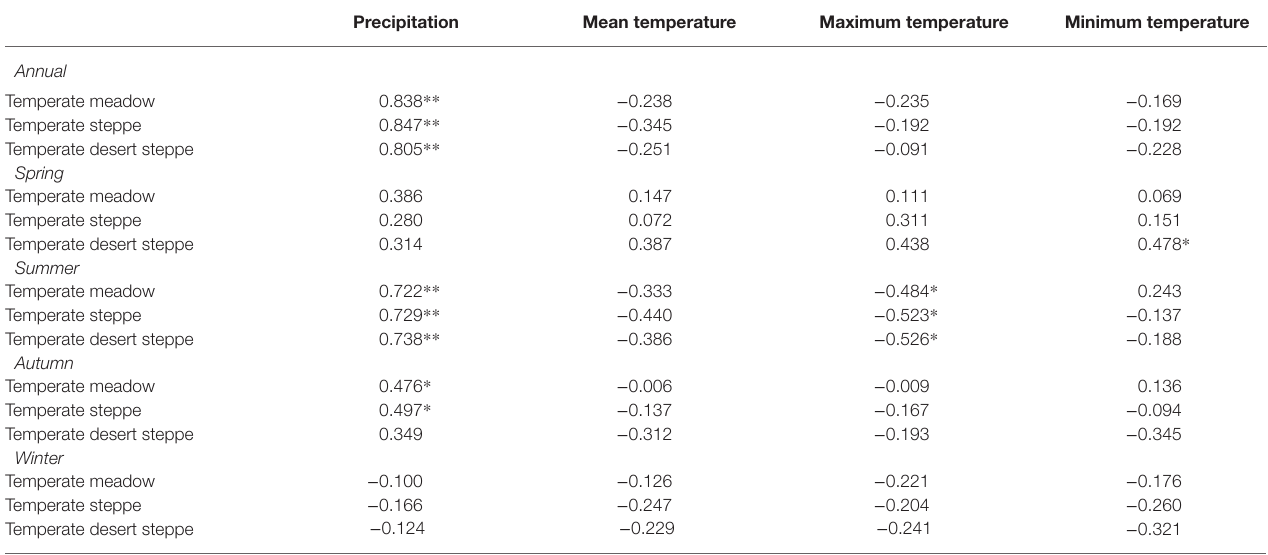
TABLE 2 | Correlation coefficients between climate variables and net primary productivity (NPP) for different grassland types of China’s temperate grasslands during 2000–2020.